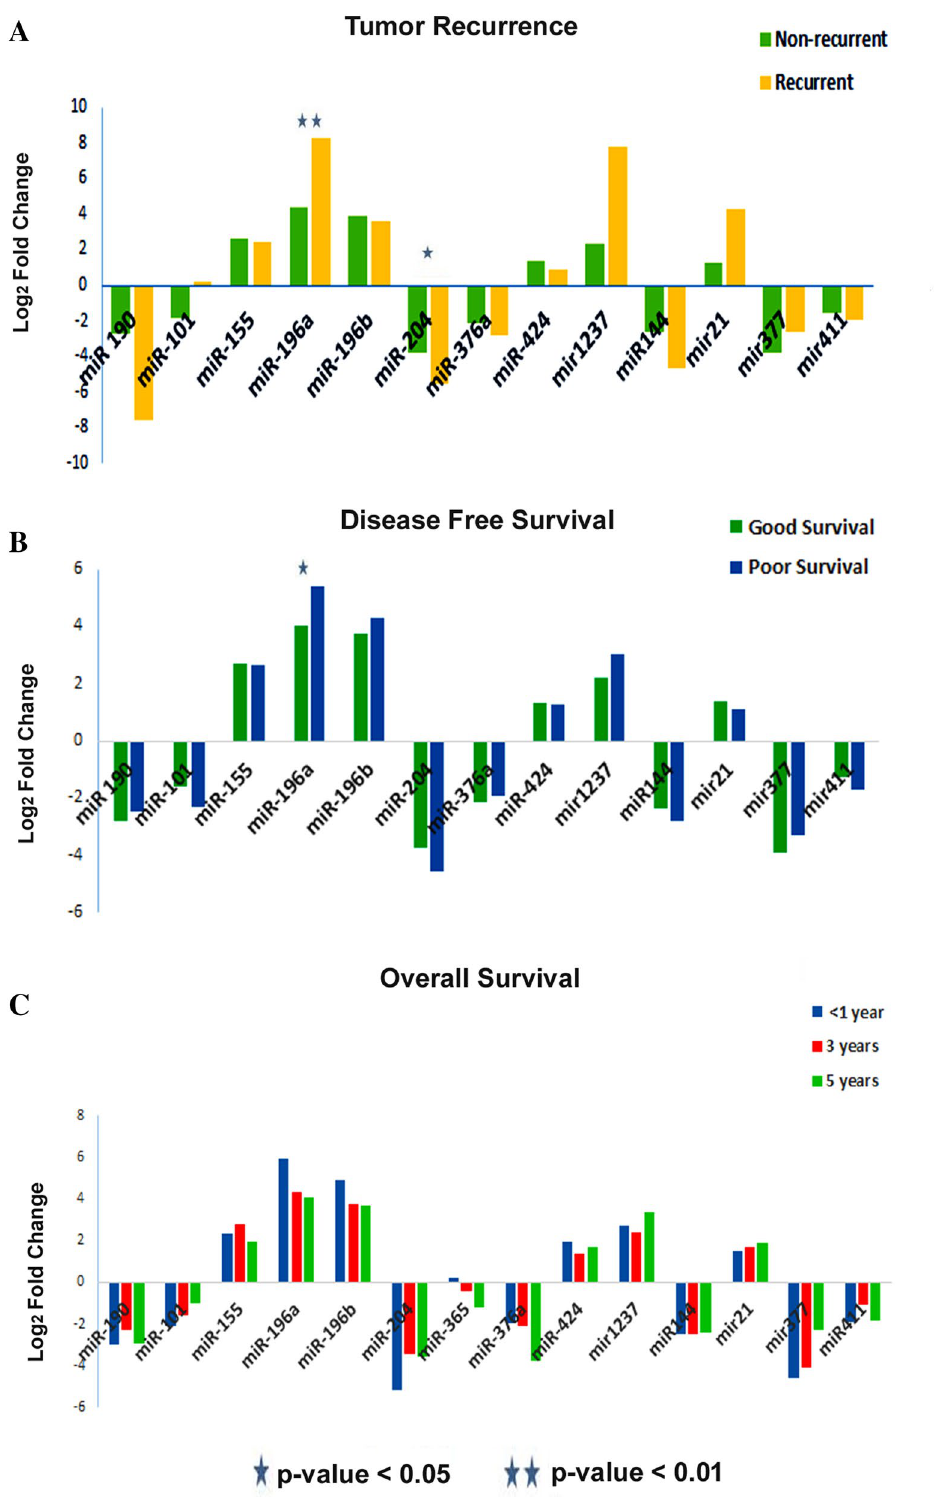
Figure 2. Validated expression profiles of signature miRNAs compared to Clinico-Pathological characteristics of patient cohort. ( A ) Tumor recurrence (Green and orange bars represent non-recurrent and reccurent tumors respectively) ( B ) Disease Free Survival (green bars for good and blue bars for poor survival) and ( C ) Overall survival (Blue bars for average < 1 year, red for average 3 years and green for average 5